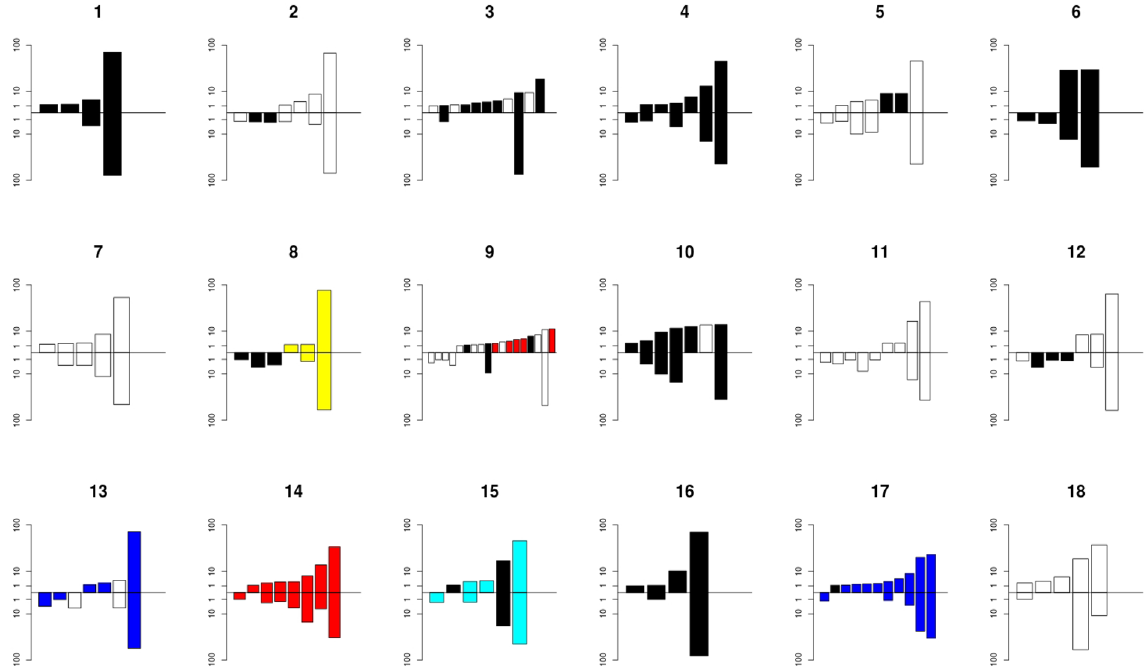
Figure 4. The number and variation of HCV haplotypes in 18 paired liver and plasma samples. The graphs indicate the number and frequency of each haplotype with a resistance mutation. The upper bars indicate the liver samples, whereas the lower bars represent plasma samples from the same patient (indicated by a number above the graphs). The colours represent different variants: Black, C316N; Red, C316H + V321I; Blue, Q309R; Cyan, C316N + Q309R; Yellow, C316Y + Q309R. Only haplotypes with a cut-off of a frequency of 1% or higher per haplotype are